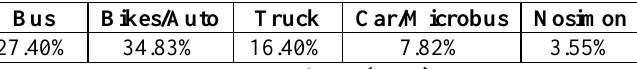
Figure 6: Vehicle, accident and fatality relationship. Table 3: Vehicle registration is increasing in linear trend but accident trend remains somehow stable in last three years Accidents by Vehicle Category.